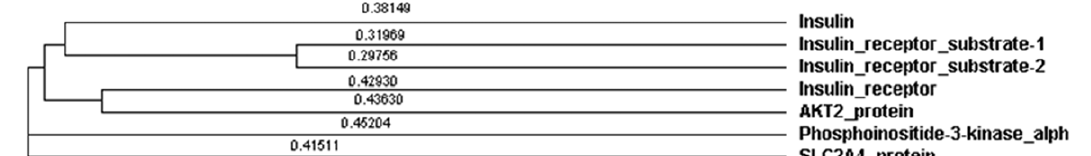
Figure 3. Phylogenetic tree construction using ClustalW.